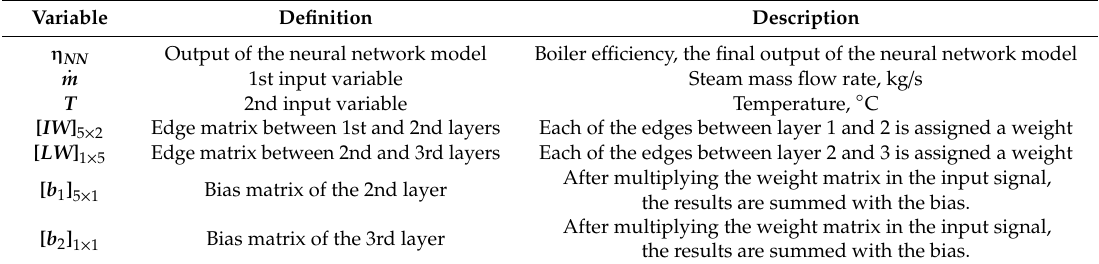
Table 2. Definition of required variables in modeling using neural network.